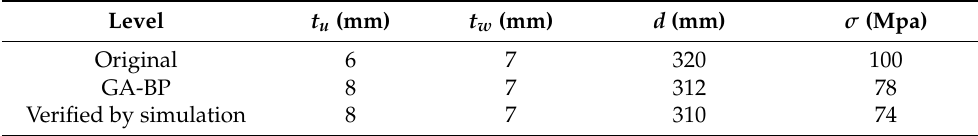
Table 3. Comparative table before and after optimization.